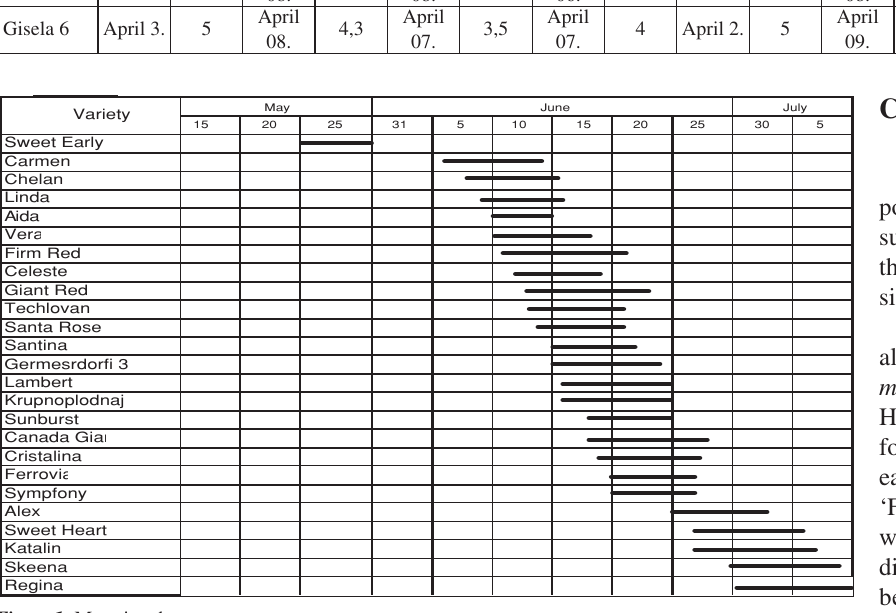
Figure 1: Maturity